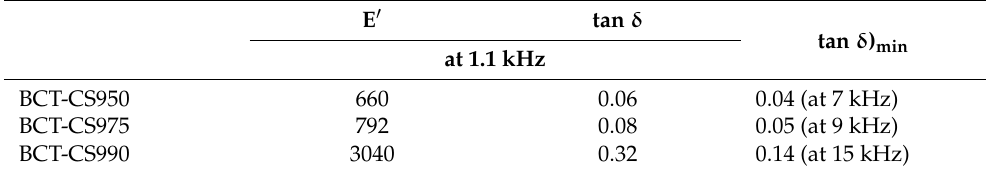
Figure 7. Room temperature spectra of ε (cid:48) and tan δ for all BCTO ceramics ( a ); the evolution of ε (cid:48) and tan δ spectra with increasing measuring temperature for ( b ) BCTO-950, ( c ) BCTO-975, and ( d ) BCTO-990 ceramic samples. Table 3. The room temperature values of ε (cid:48) and tan δ at 1.1 kHz and the minimum dielectric loss value tan δ ) min for BCT